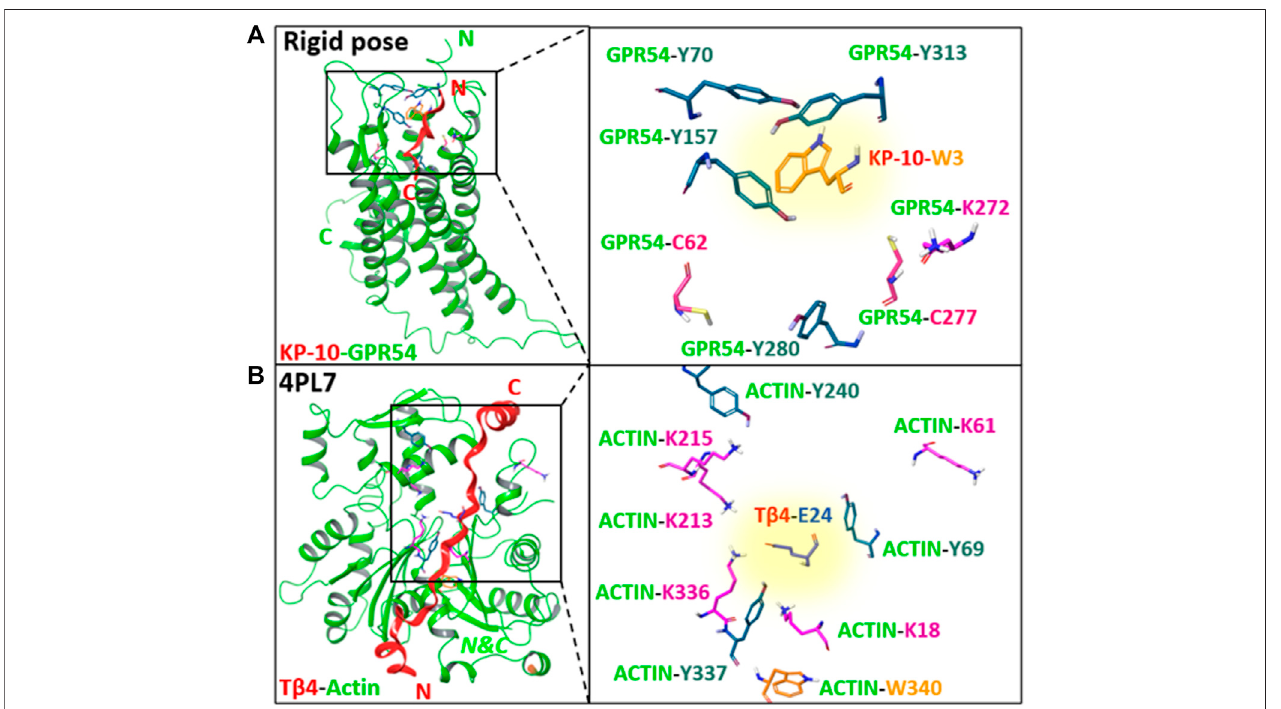
FIGURE 2 | (A) The best predicted docking pose of the native kisspeptin-10 ligand into the GPR54 model receptor structure using the rigid pose conformation of thereceptor. (B) 3DstructureofT β 4-actincomplexbasedonPDB4PL7.Leftpanels:anoverviewofthecomplexsystem;rightpanels:zoominonGPR54/ACTINamino acids side chains (Lys, Cys, Tyr, and Trp) proximate to KP-10- W3 or T β 4- E24 , respectively, without the secondary structure. The amino acid that is replaced by furylalanine(W3inkisspeptin,E24inThymosin β 4)ishighlightedwithayellowbackground.N,C=N-,C-termini . ImagespreparedusingMAESTRO(fordetails,see ESI